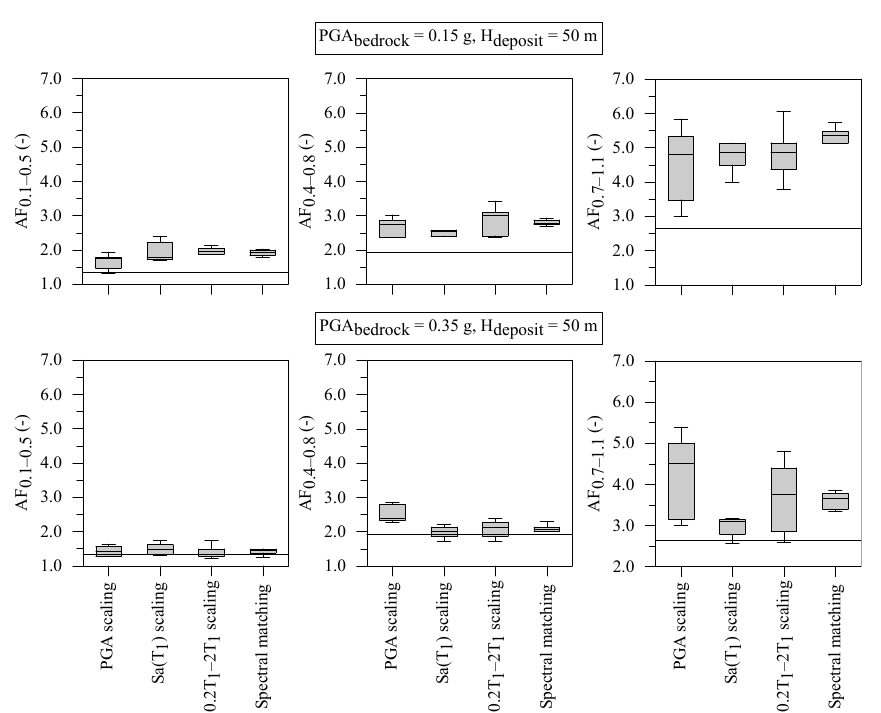
Figure 12. Box plots of AFs for a deposit thickness equal to 50 m and V S2 (z), considering 4 selection strategies for the input motions. The constant value retrieved from EC8 (thin black line) refers to ground type D.